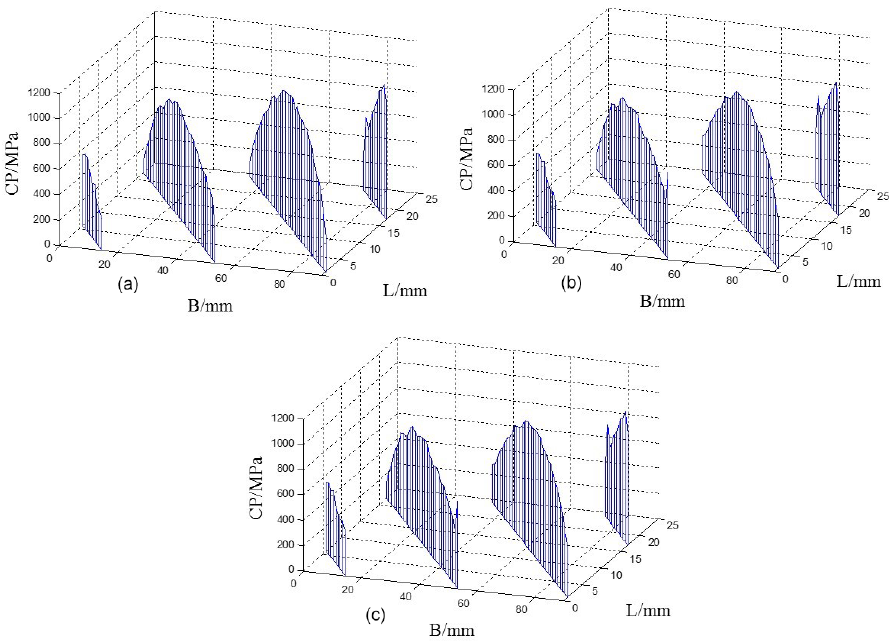
Figure 24. Contact stress distribution of the right tooth surface with three different modification values of the U -shaped power flow. (a) Maximum amount of modification at 37µm. (b) Maximum amount of modification at 28.5µm. (c) maximum amount of modification at 18.5µm.